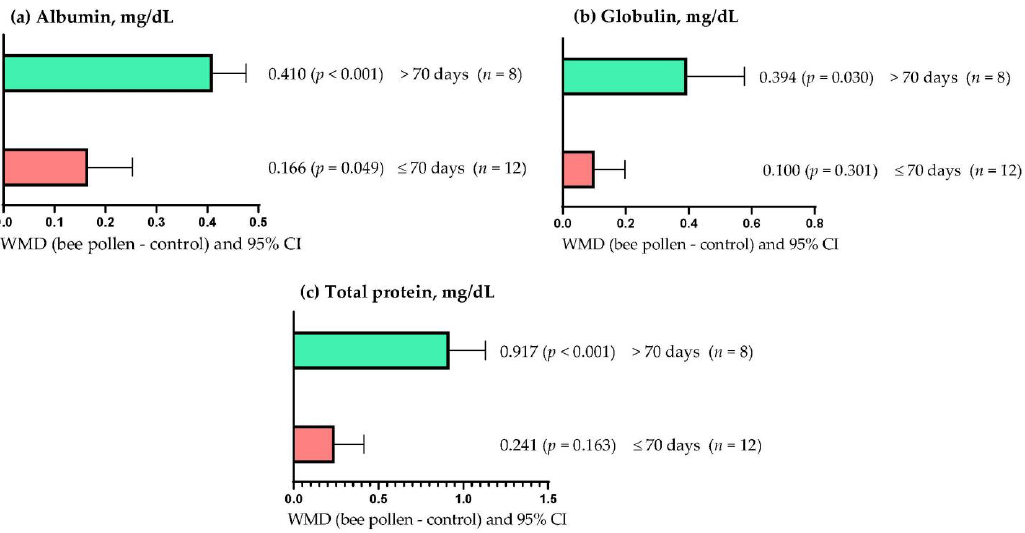
Figure 2. Subgroup analysis (subgroup = supplementation period (days)) of the effect of bee pollen supplementation in rabbits, WMD = weighted mean differences between bee pollen treatments and control.